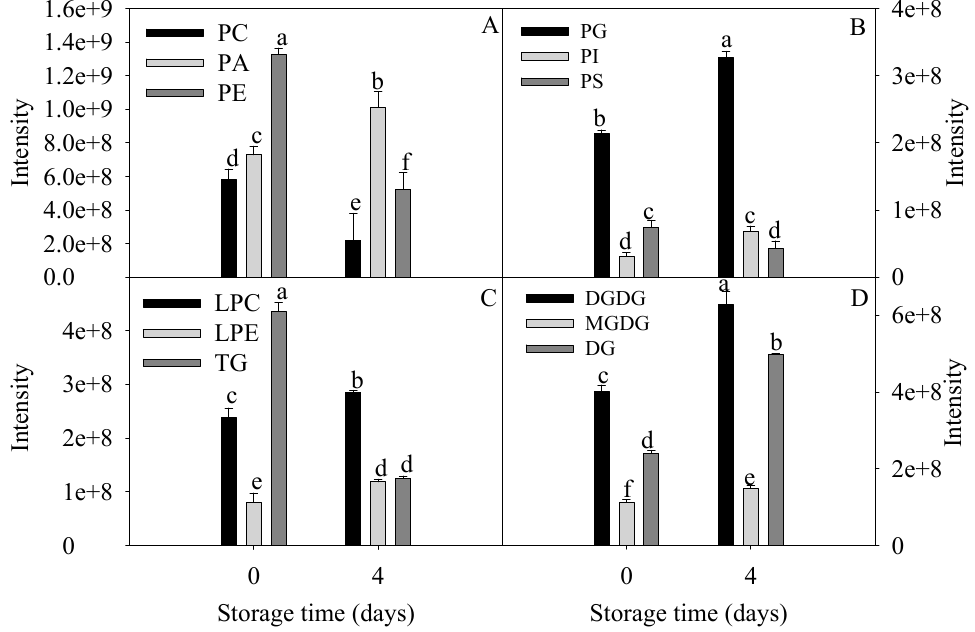
Figure 3. The relative content of lipid class with significant differences of banana fruit stored at 0 and 4 days at 6 °C. The content of each lipid species was presented as mean intensity ± standard error ( n = 5). The means with different letters were significantly different ( p < 0.05).